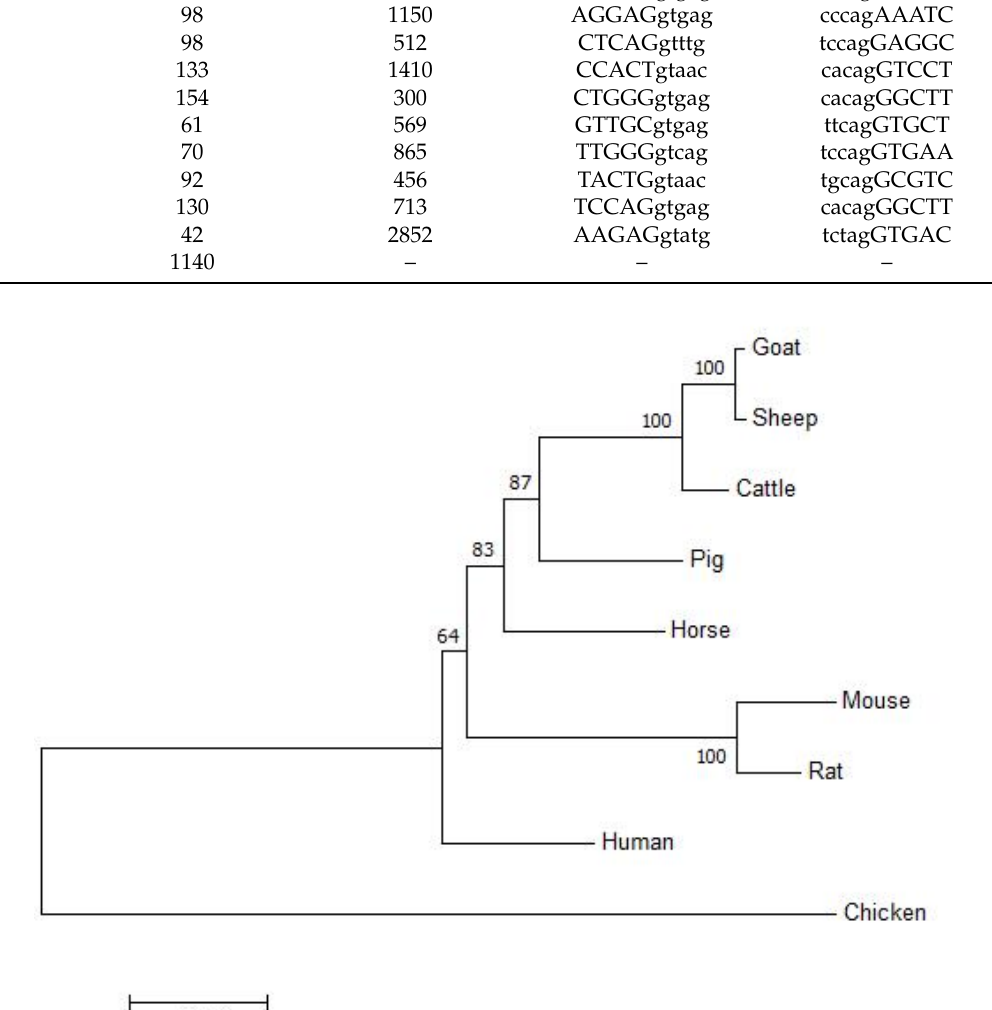
Figure 2. The neighbour-joining phylogenetic tree of GHRHR protein sequences in nine animals.